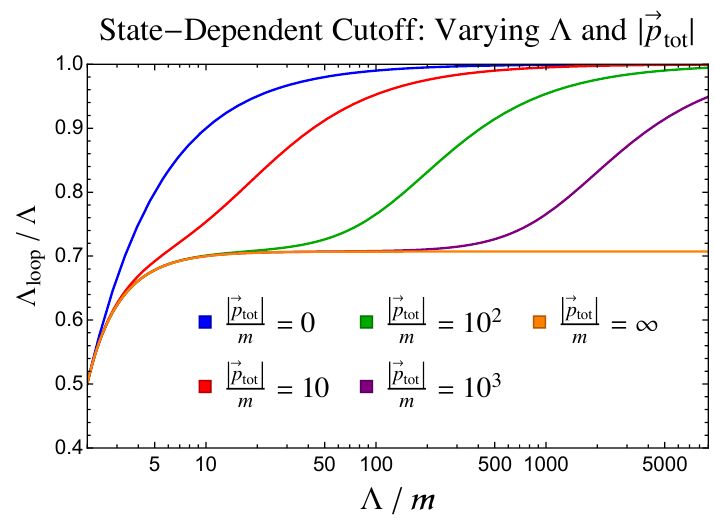
Figure 15 . Effective cutoff Λ loop (in units of the UV cutoff Λ ) as a function of Λ for different values of | ~p , when the external state is the lowest two-particle state. For any finite value of | ~p tot | effective cutoff eventually reaches Λ , but for | ~p